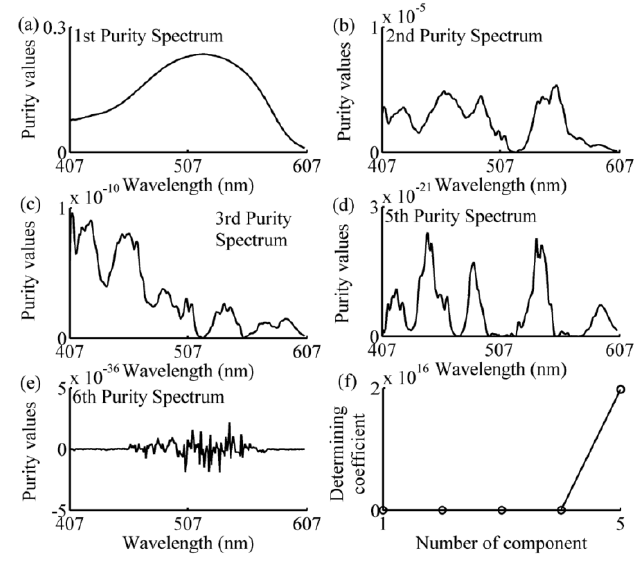
Figure 8. Purity spectra and determining coefficient during the processing of one-component sample’s calibration subset spectra. ( a ) 1st purity spectrum; ( b ) 2nd purity spectrum; ( c ) 3rd purity spectrum; ( d ) 5th purity spectrum; ( e ) 6th purity spectrum; ( f ) determining coefficient. The component is amaranth (160 μg/mL).